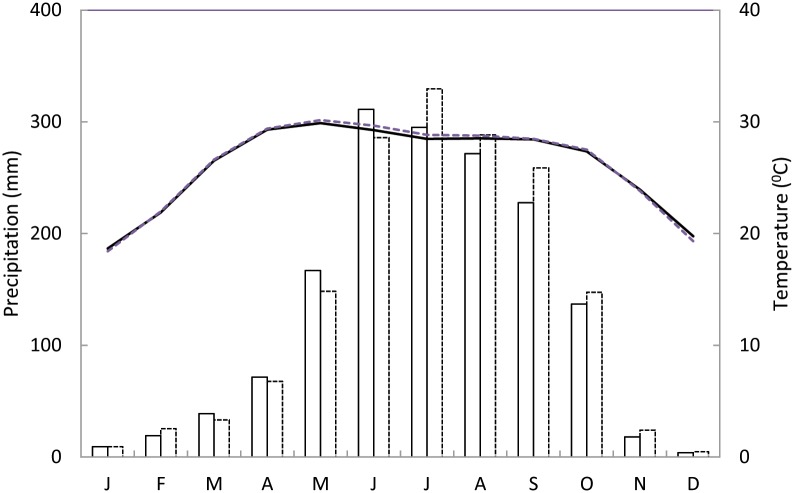
The climate diagram of the study area.The bar and line represent precipitation and temperature, respectively. The solid line is for Khulna station (eastern zone of the study area) and dotted line for Satkhira station (western zone of the study area). Average data for the period of 1948 to 2011.